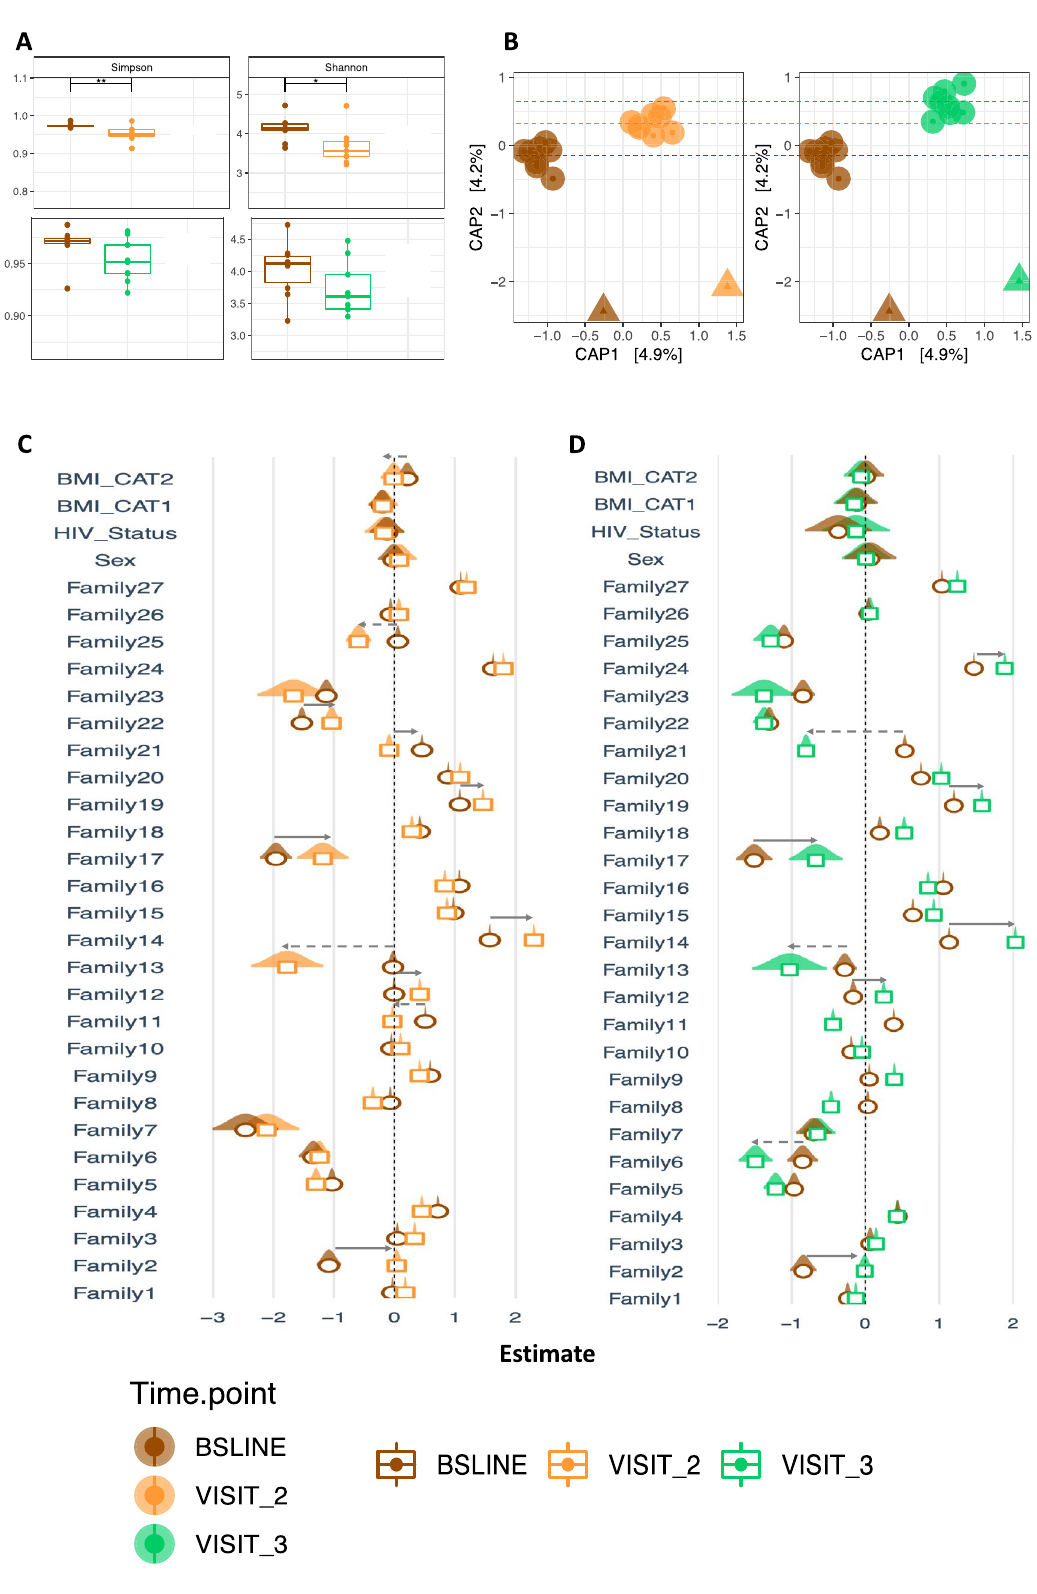
Figure 8. Analysis of the magnitude and direction of change relative to baseline. This figure is based database C of Fig.